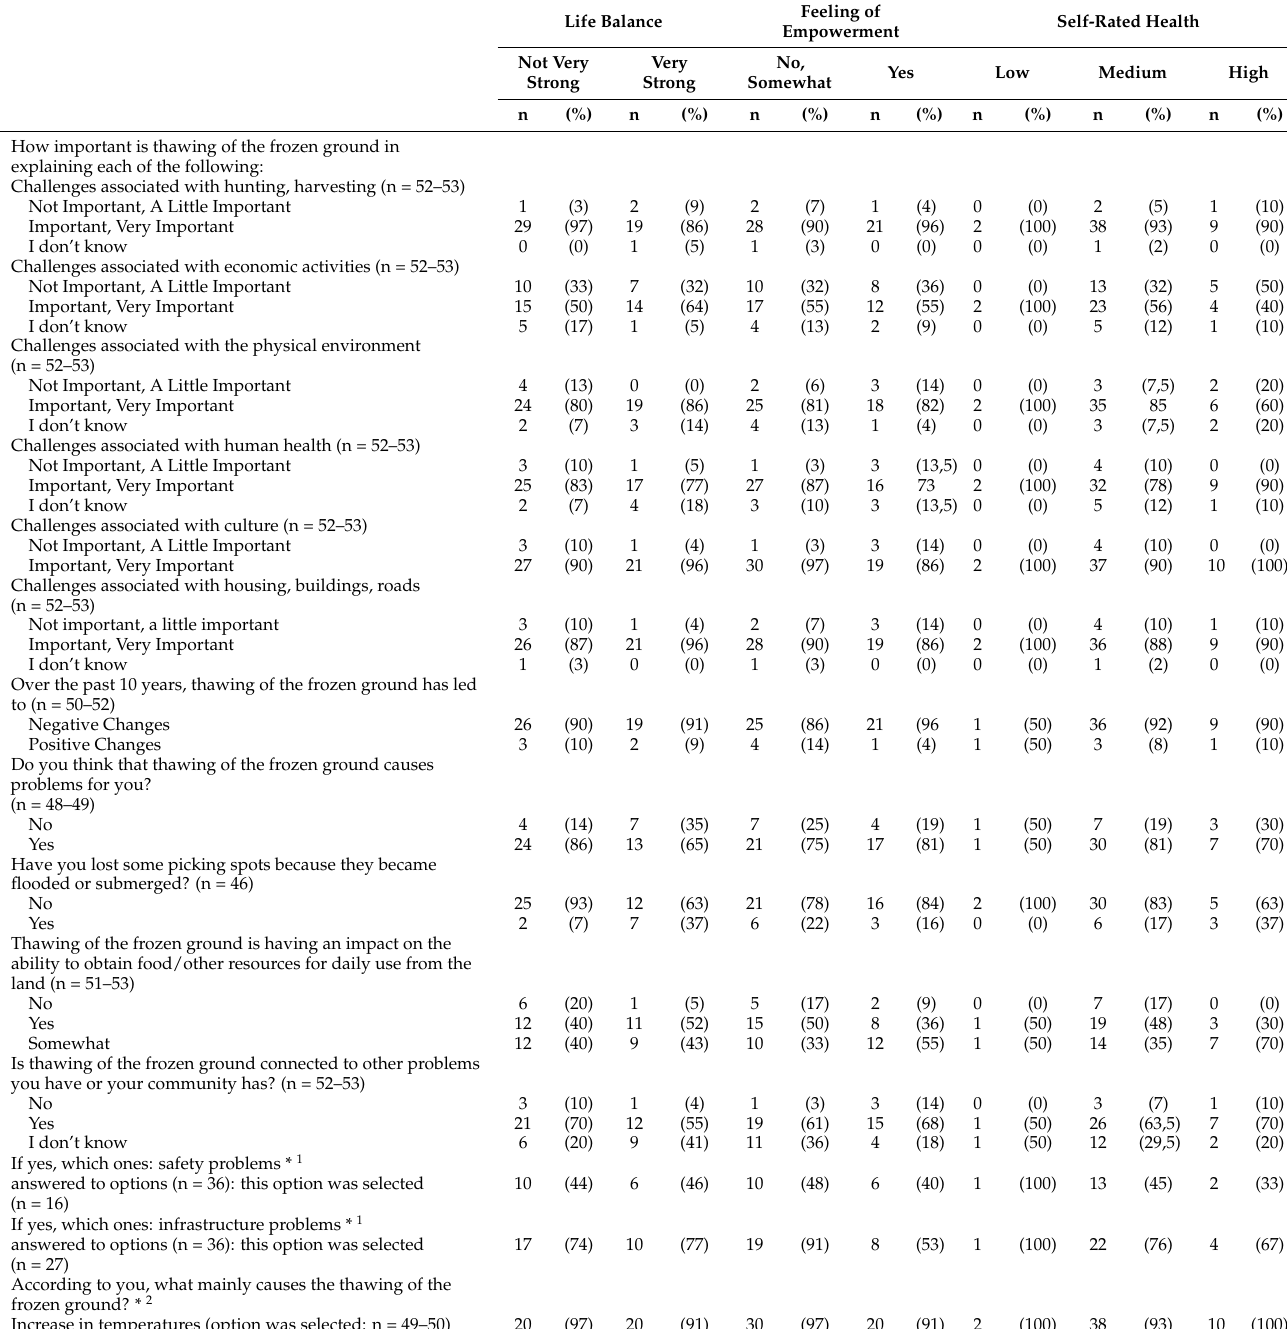
Table 3. Self-rated health, life balance and feeling of empowerment to face changes and perceived challenges/impacts related to permafrost